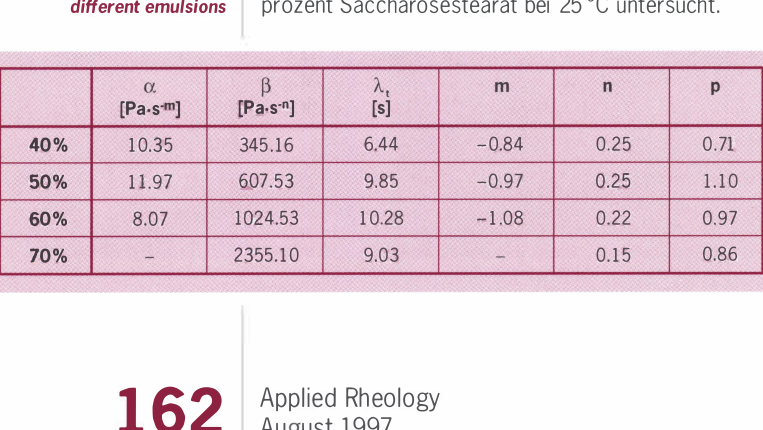
Tabel/e 1: Fitparameter fiir die Anpassung der Relaxationszeitspektren der verschiedenen Emulsionen an Gleichung (10} Table 1: Fitting parameters, according to Equation (10], for the relaxation spectrum corresponding to the different emulsions